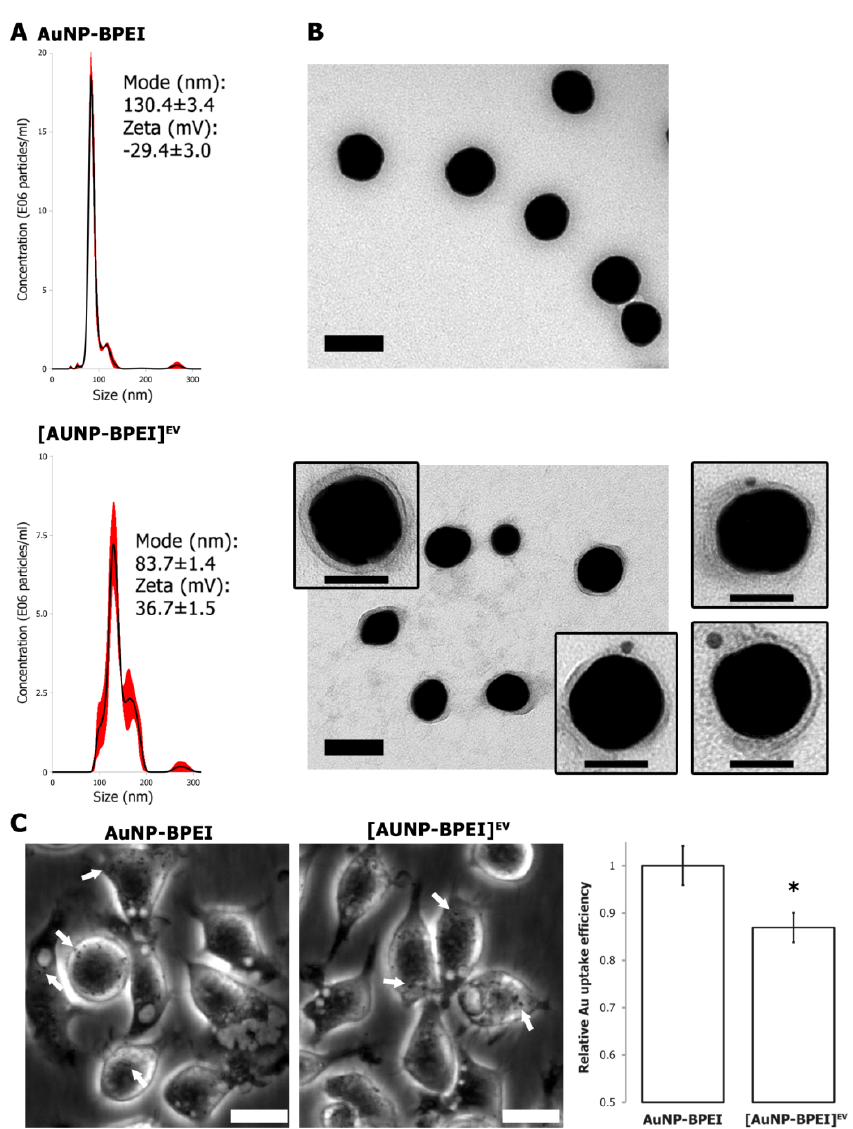
Figure 4. Functionalization of AuNP by EV membranes. ( A ) NTA size distribution of AuNP-BPEI versus AuNP-BPEI cloaked with EV membranes, depicted as mean (black line) with standard error (red shaded area). Inset: size mode (nm) and mean zeta potential (mV) ± standard error. ( B ) Transmission electron microscopy of AuNP-BPEI and EV-cloaked AuNP-BPEI. Scale bar: 100 nm. Inserts: CD9 immunoelectron microscopy of EV-cloaked AuNP-BPEI. Scale bar: 50 nm. ( C ) Left panels: Phase contrast images of J774A1 macrophages after 16 h incubation with AuNP-BPEI or [AuNP-BPEI] EV . White arrows indicate phagocytosed AuNP aggregates. Scale bar: 20 µm. Right panel: Quantification of AuNP uptake by determination of total Au concentration via ICP-MS. Asterisk indicates significantly different value (*, two-sided t-test, p = 0.01).